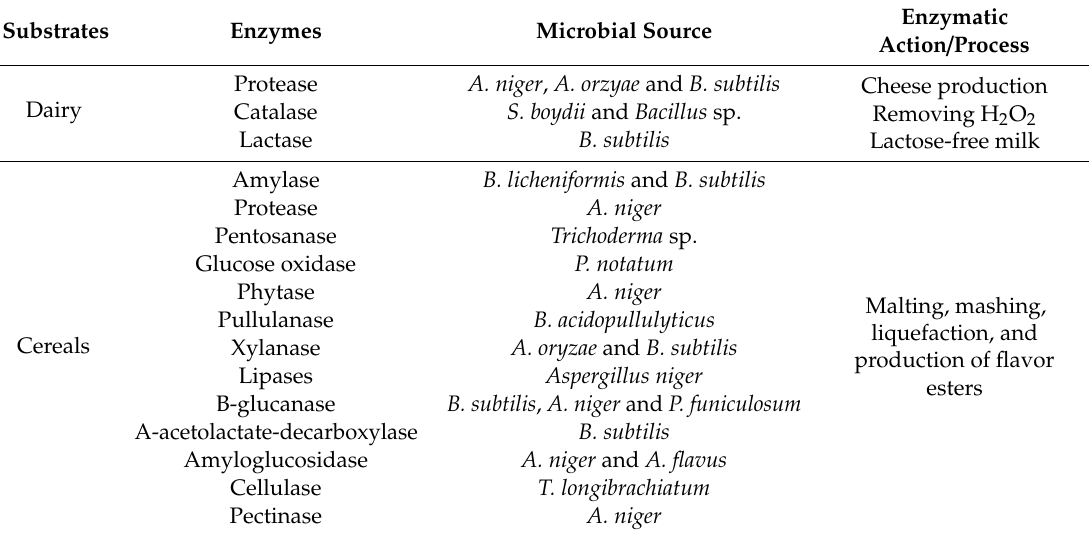
Table 2. Some essential commercial enzymes used in fermented foods /